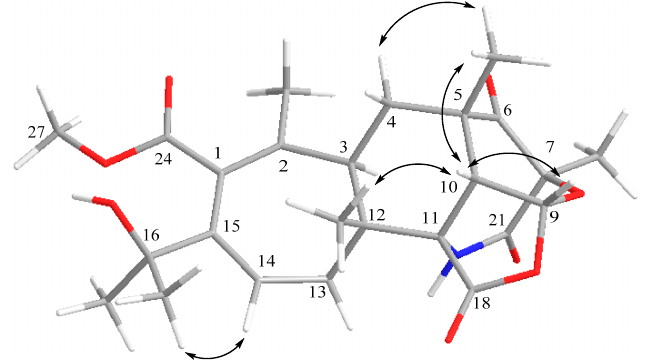
Figure 7. Key NOESY correlations of compound 1 .